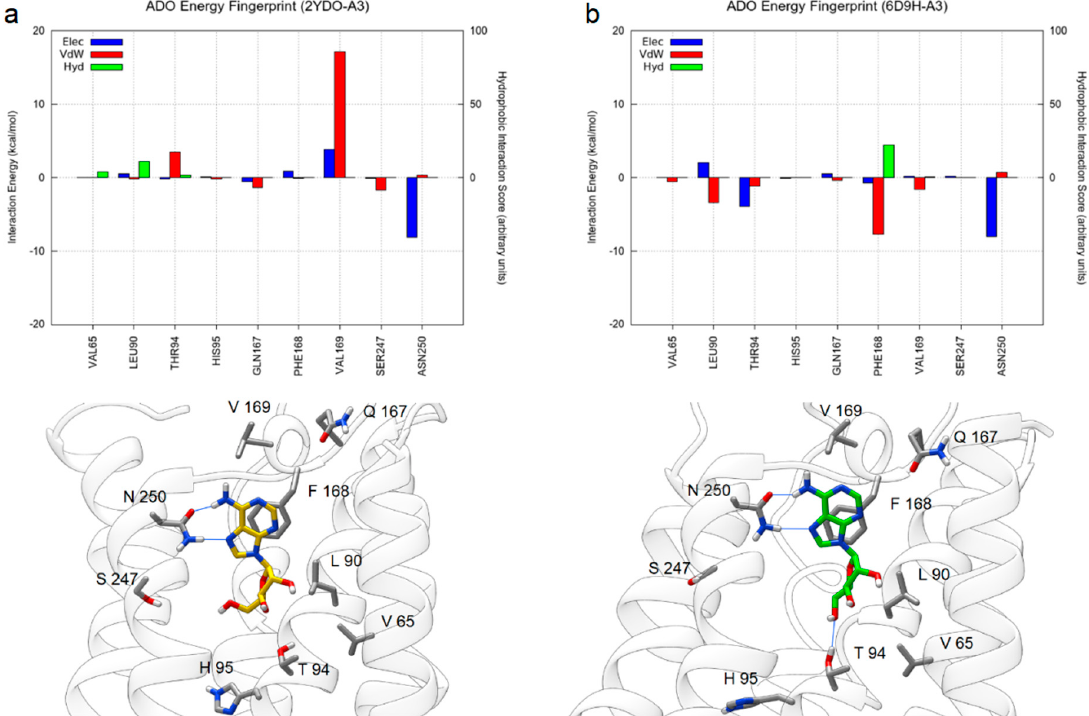
Figure 6. Per residue energy histograms and selected docking pose of adenosine on either the hA 2A based model ( a ) or the induced fit hA 1 -based model ( b ).